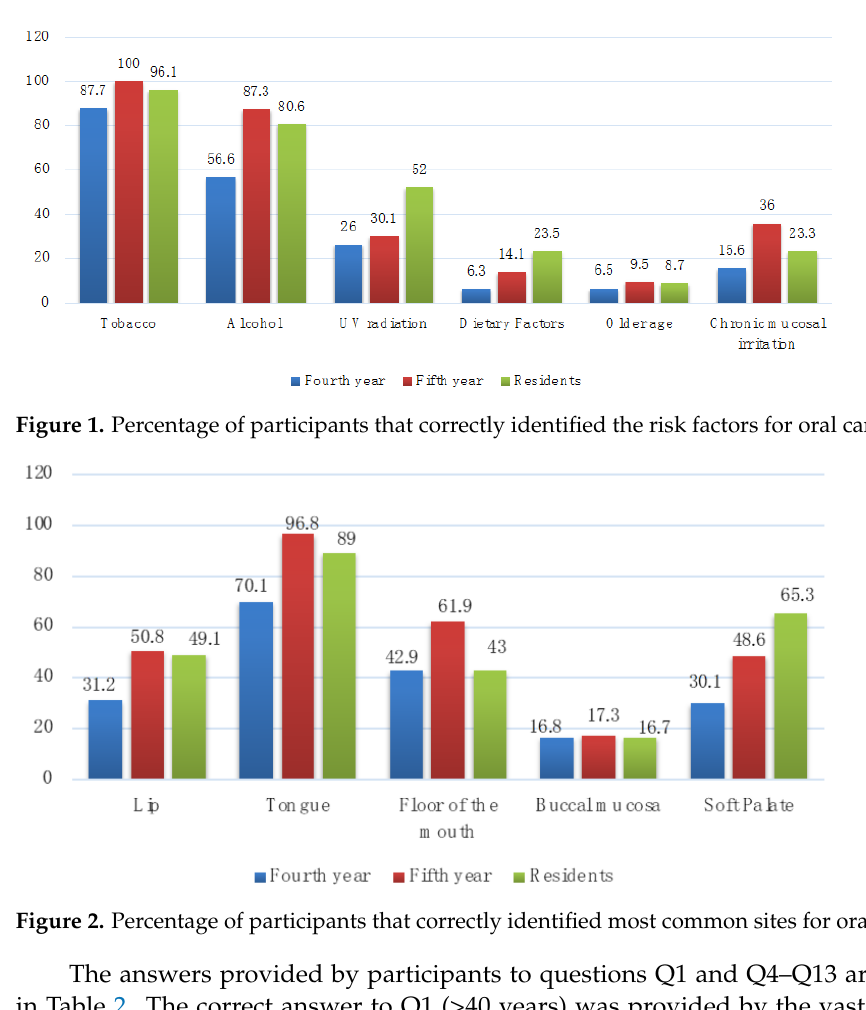
Figure 2. Percentage of participants that correctly identified most common sites for oral cancer (Q3).